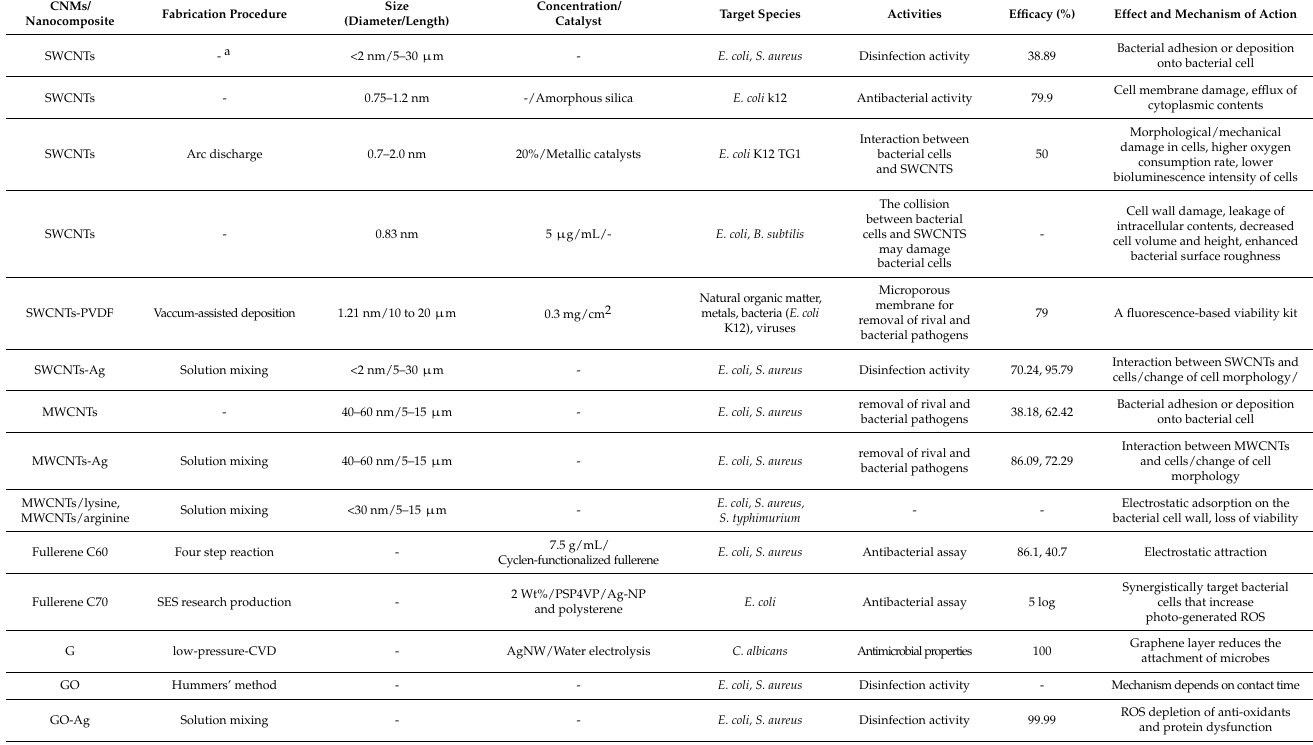
Table 2. Antimicrobial activities of various carbon nanomaterials against specific pathogens. Adopted from